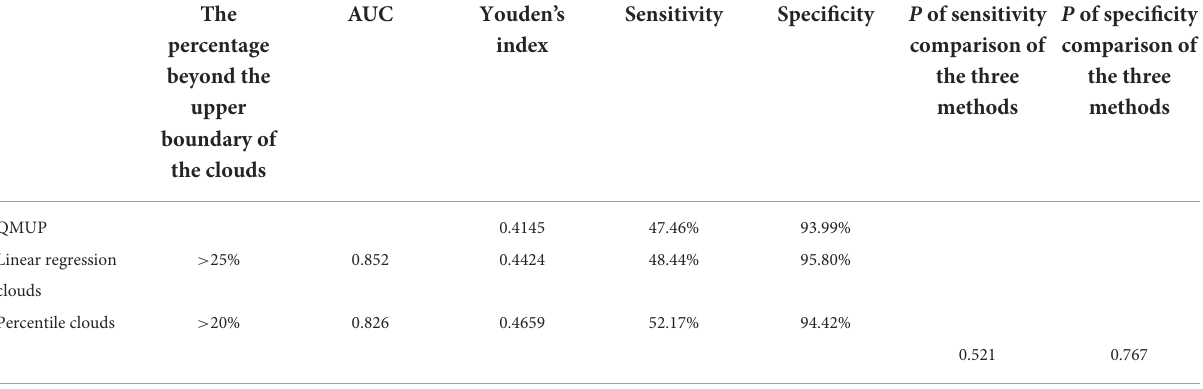
TABLE 9 The sensitivity and specificity of each method for discrimination of neuropathic vs. non-neuropathic lesion muscles.